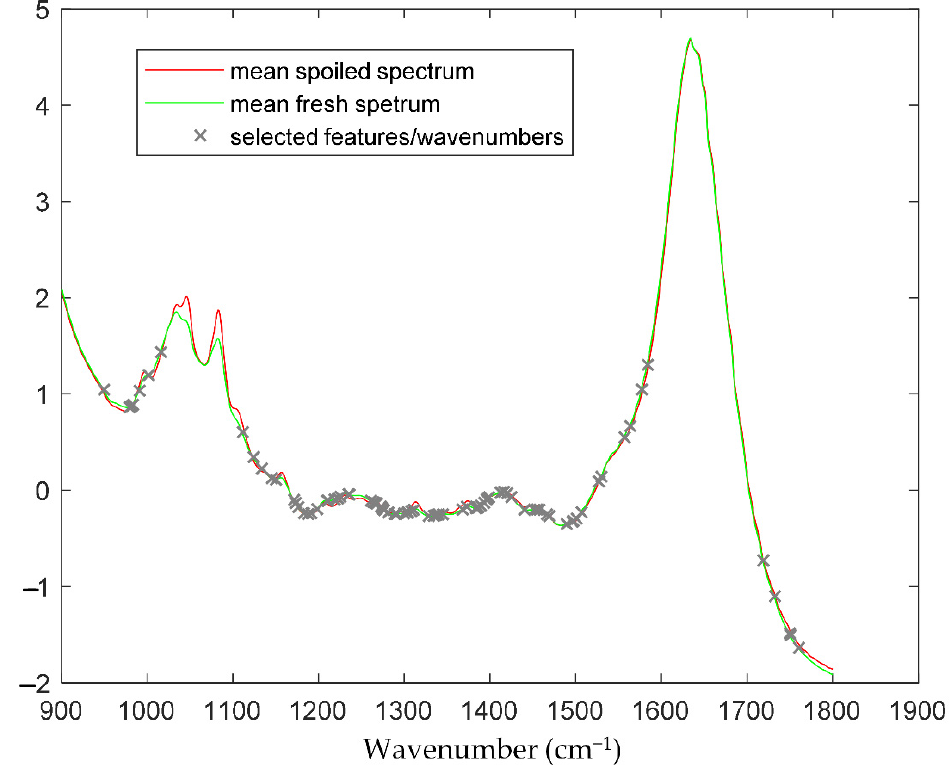
Figure 2. Average spectra for the fresh (green line) and spoiled (red line) of all samples (MI, SAMS and harvest year). Grey “ × ” symbols indicate the selected significant features/wavenumbers, ensuring that the wavenumbers implicated as the origin of the samples will not be taken into account by the developed prediction model.